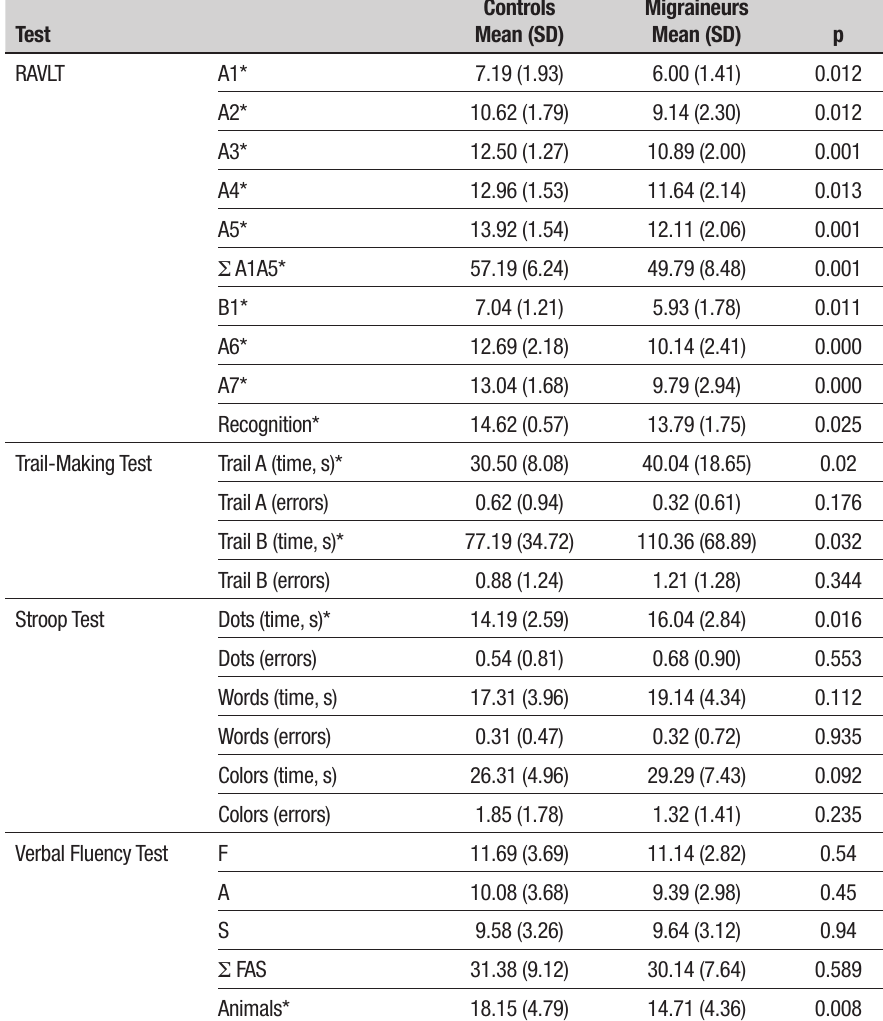
Table 2. Performance on neuropsychological tests Test